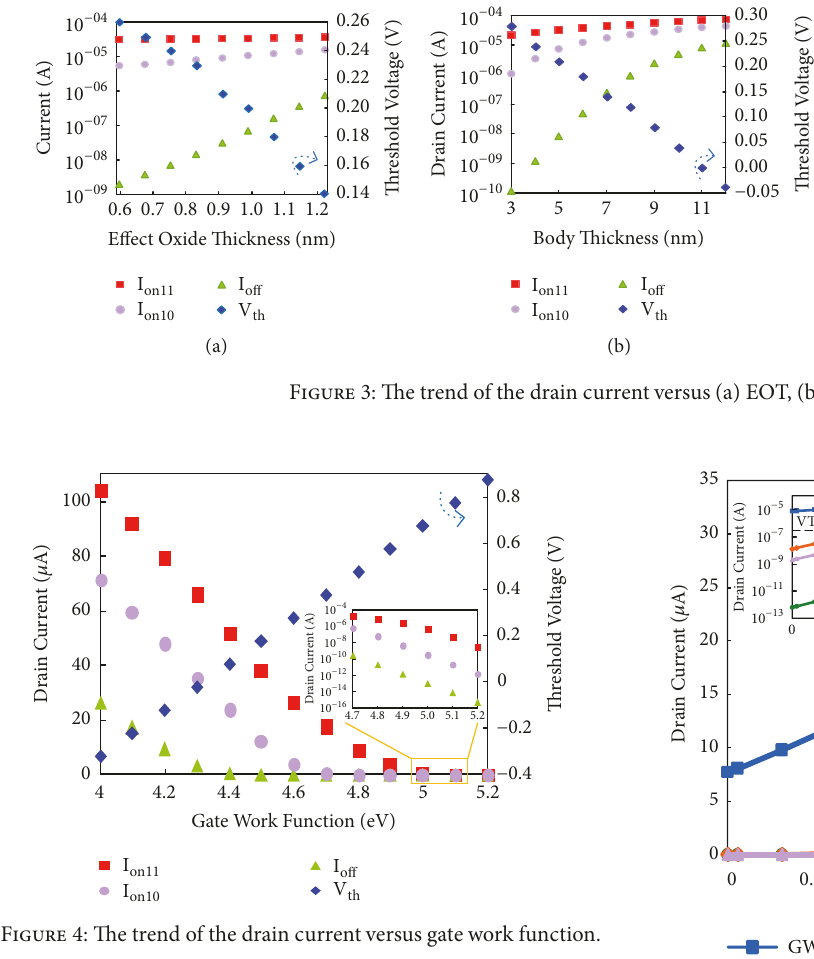
plotted as symbols in Figures 5 and 6, and the subgraphs in the main diagrams are the same plots of logarithmic coordinates, and the dashed lines in figures are cutoff current lines. When the drain current rises to up the cutoff current line, the transistor will turn on, otherwise, the transistor will turn off when the drain current drops down to below the cutoff